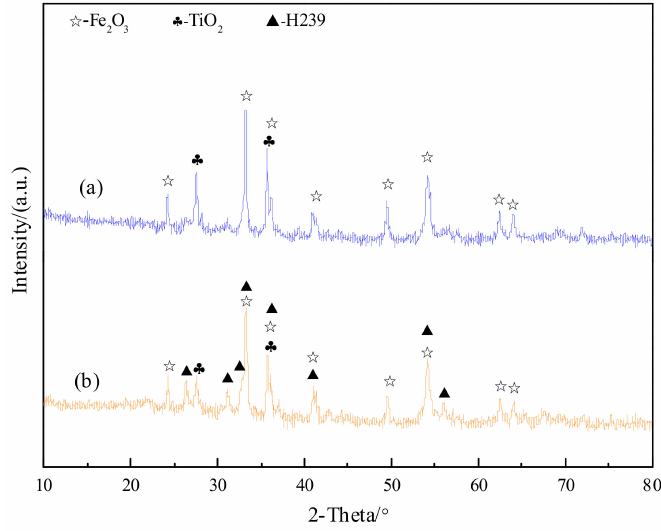
Figure 7. Chemical transformations of natural ilmenite at 800 ◦ C for 60 min for ( a ) A0 and ( b ) A1.